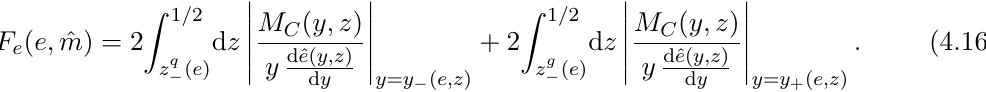
( e ) and z g ( e ), marked with (cid:0) (cid:0)